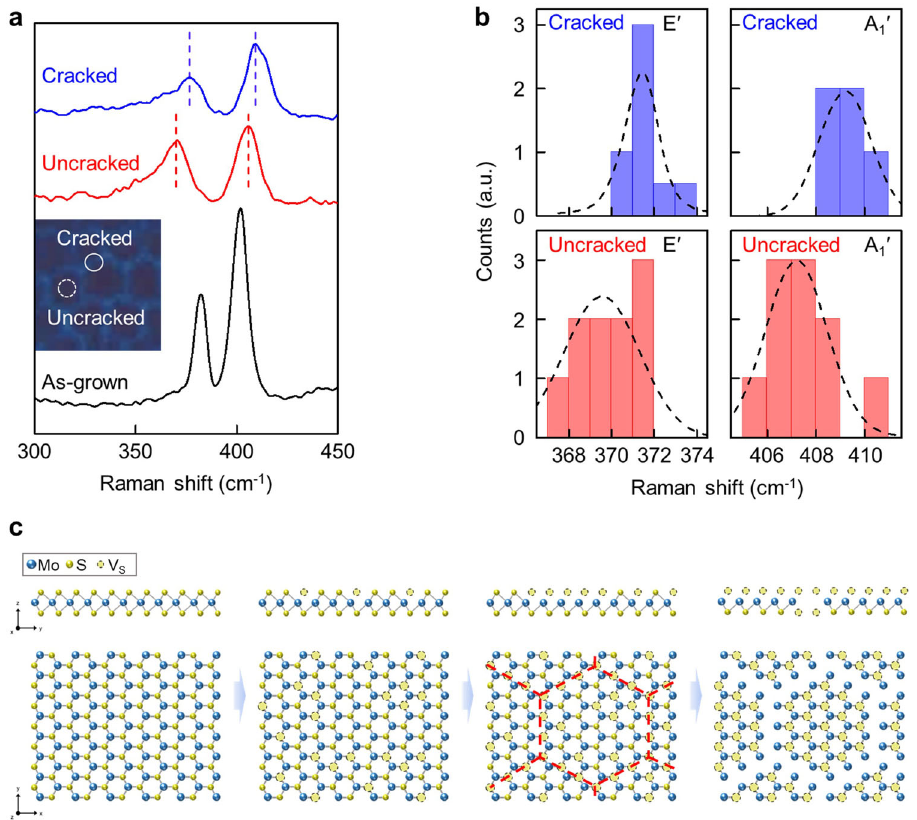
Fig. 5 Strain-related evolution of Raman spectra and formation of cracks. Representative Raman spectra ( a ) and E ′ , A 1 ′ peak positions ( b ) extracted from cracked and uncracked region in HP-MoS 2 (30 min). The inset in a shows two spots for Raman measurement. c The schematic diagram of the one-atom- thick surface engineering process. The red lines highlight the location of sulfur vacancies along zigzag